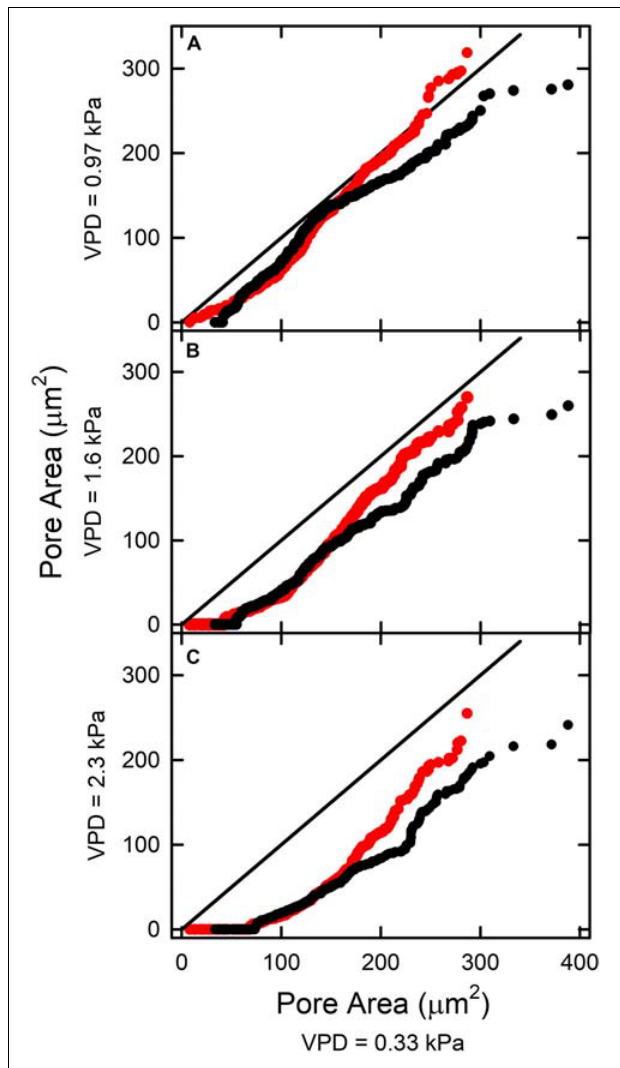
FIGURE 4 | The relationship between stomatal pore area at elevated VPD [ (A) 0.97 kPa; (B) 1.6 kPa; (C) 2.3 kPa] and pore area measured at low VPD (0.33 kPa). The AA treatment is shown in black, and the FA treatment in red. The solid line represents the 1:1